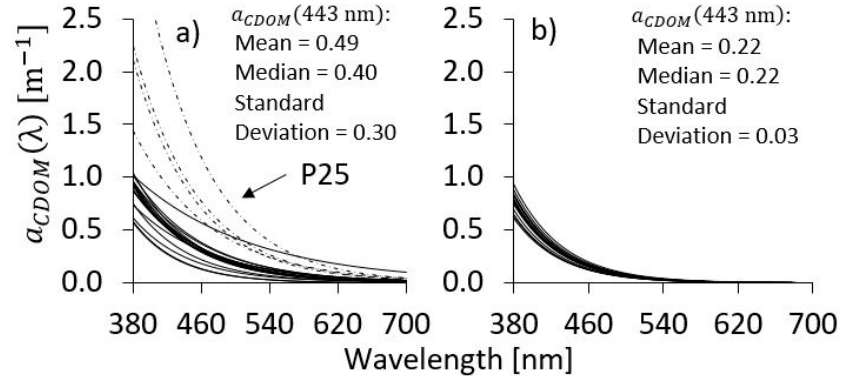
Figure 8. Field values for ( a ) 2013 a CDOM ( λ ) ; and, ( b ) 2019 a CDOM ( λ ) .